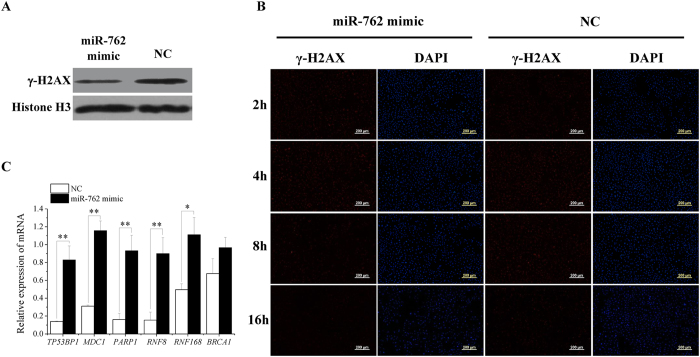
miR-762 promotes DNA damage repair.ST cells were transfected with the miR-762 mimic or NC. (A) After transfection for 48 h, γ-H2AX protein levels were detected using western blotting. (B) After transfection for 24 h, ST cells were irradiated with ultraviolet light for 20 s to cause DNA damage, γ-H2AX protein levels were tested using immunofluorescence after irradiation for 2 h, 4 h, 8 h and 16 h. γ-H2AX was positive for secondary antibody (red), and the cell nuclei were positive for DAPI (blue). Scale bar = 200 μm. (C) The mRNA expression levels of TP53BP1, MDC1, PARP1, RNF8, RNF168 and BRCA1 were detected 24 h after transfection. **P < 0.01, *P < 0.05.